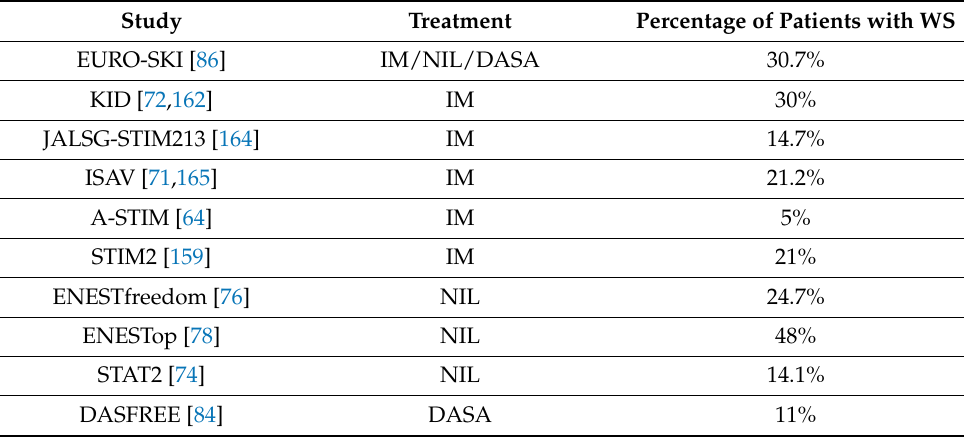
Table 6. TKI withdrawal